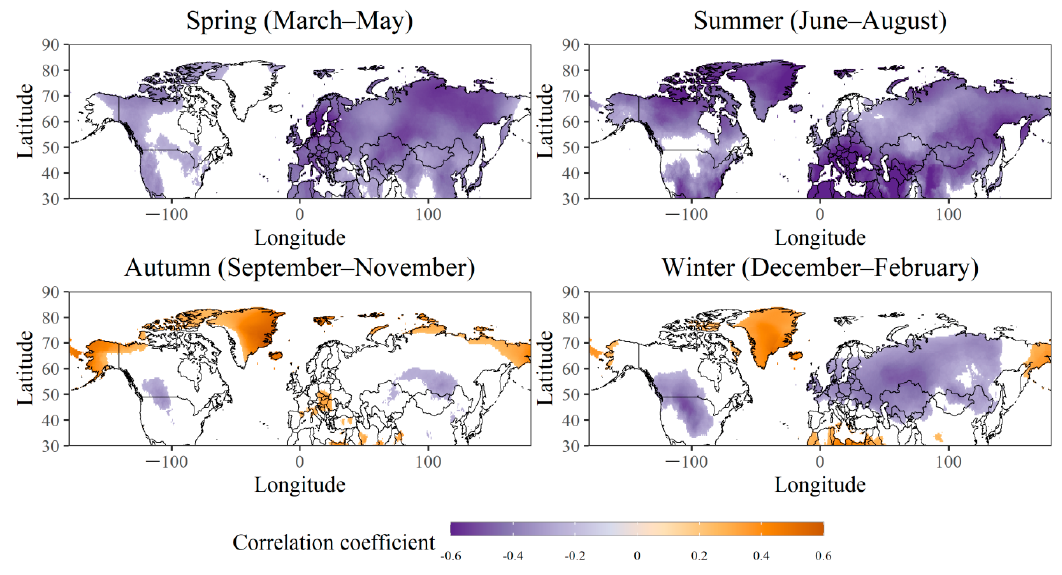
Figure 7. Map of the correlation coefficients between seasonal SCE and seasonal temperature over the NH during the period of 1967–2018. Only the significant ( p < 0.1 ) correlations are shown.